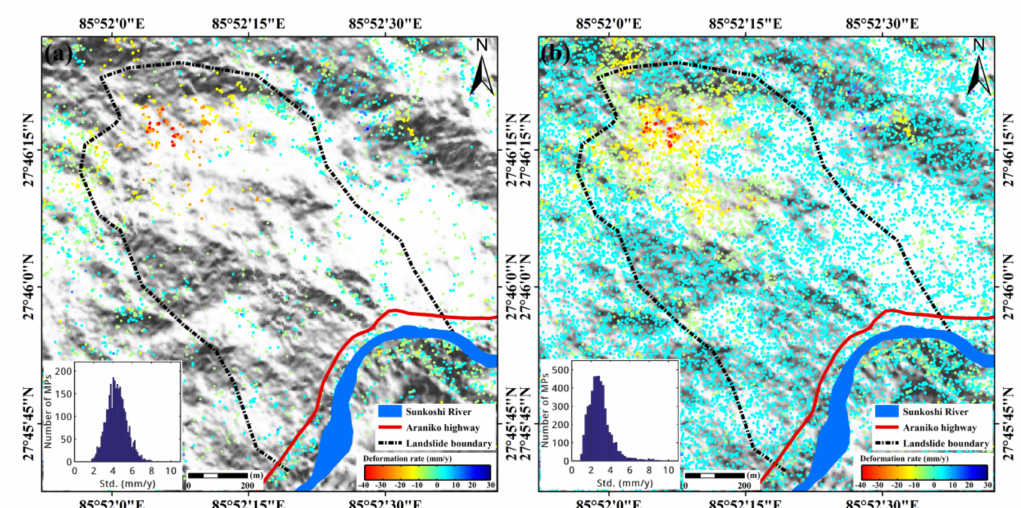
Figure 5. Results of pre-disaster annual deformation rate of Sunkoshi landslide derived by ( a ) SBAS and ( b ) CSI methods, separately. The Sunkoshi River and Araniko Highway are rendered in their original locations before destruction. The subfigures on the lower-left corner show the histograms of standard deviation distribution of deformation